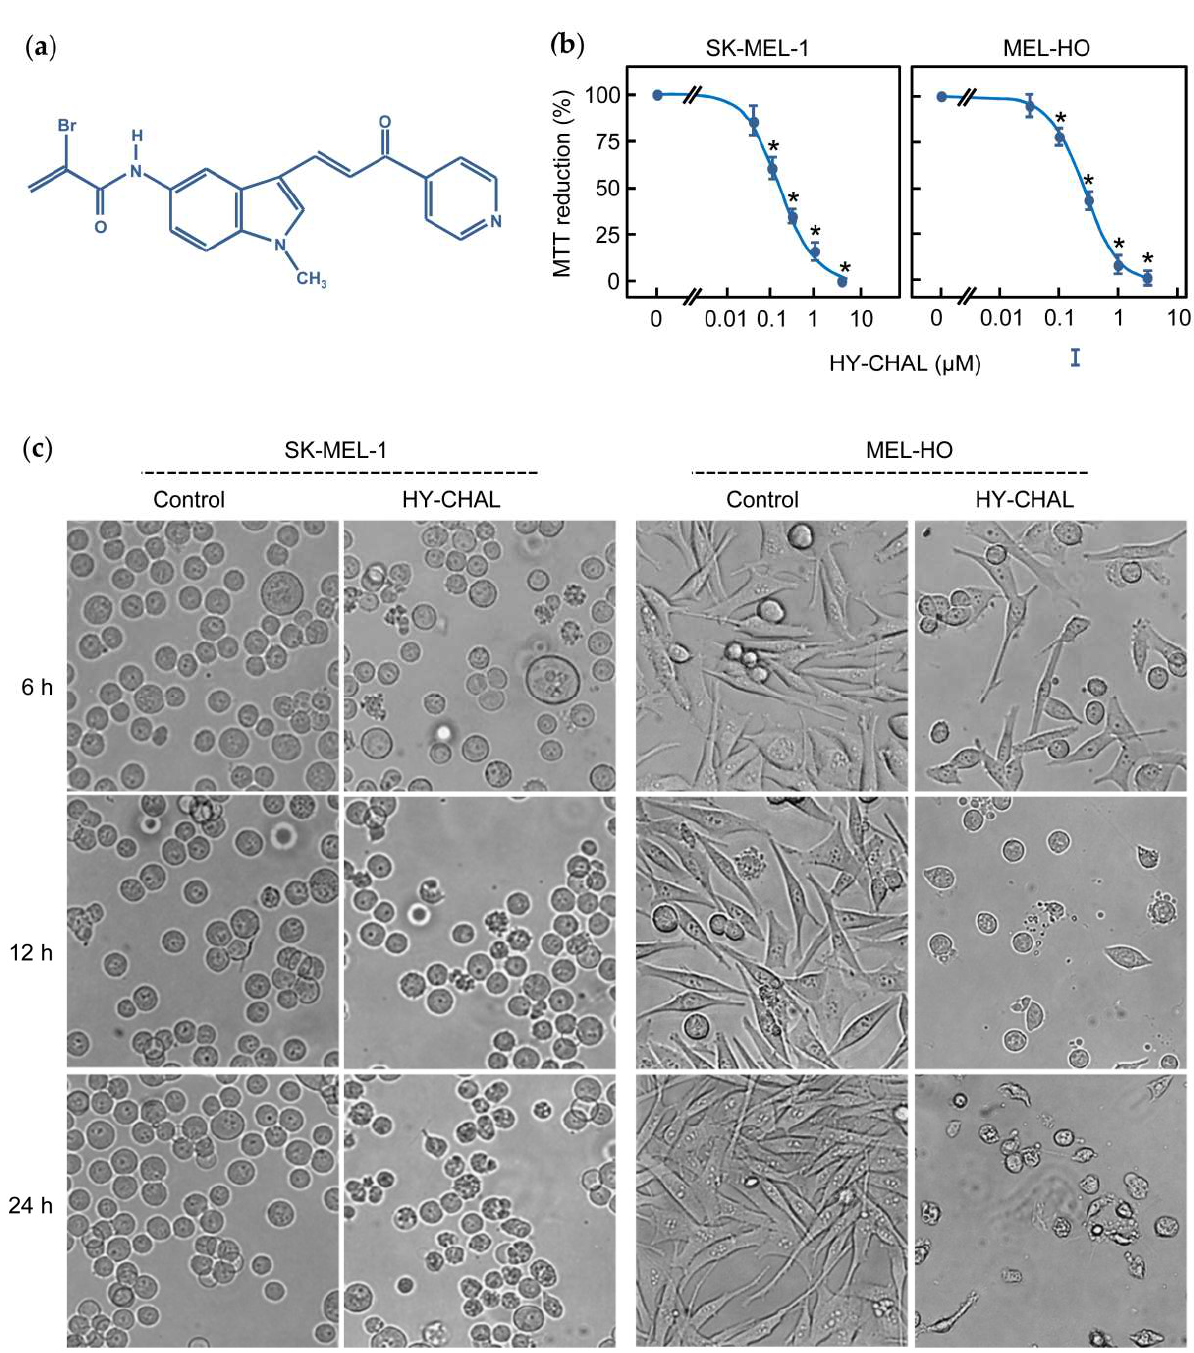
Figure 1. The hybrid chalcone (HY-CHAL) reduced the viability of human SK-MEL-1 and MEL-HO melanoma cells. ( a ) Chemical structure of the synthetic HY-CHAL; ( b ) Dose-response study on MTT reduction (means ± SEs; * indicates significant difference from the control at 0.05 significance level). Cells were incubated in the presence of increasing concentrations of HY-CHAL for 72 h, and thereafter mitochondrial respiratory function was determined by the MTT assay; ( c ) Cells were incubated with 3 µ M HY-CHAL for different time periods and images were obtained with an inverted phase-contrast microscope; original magnification 20×.